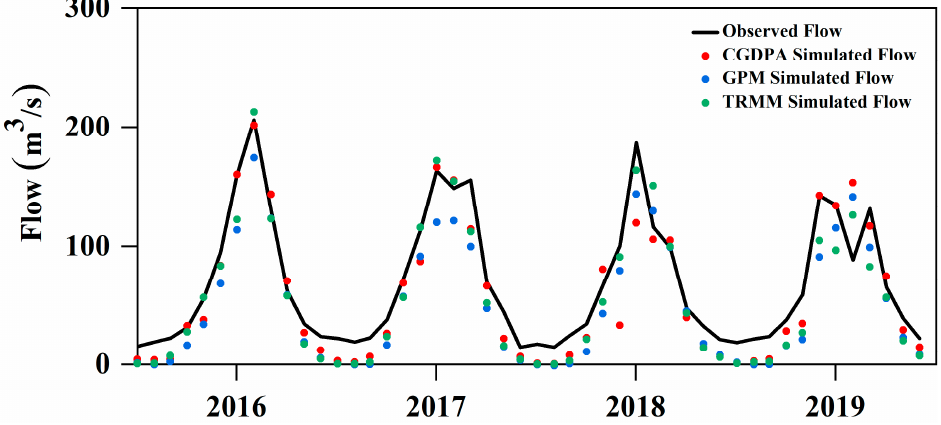
Figure 4. Plot of the simulated runoff via the TVGM-DDF with the variable parameter.